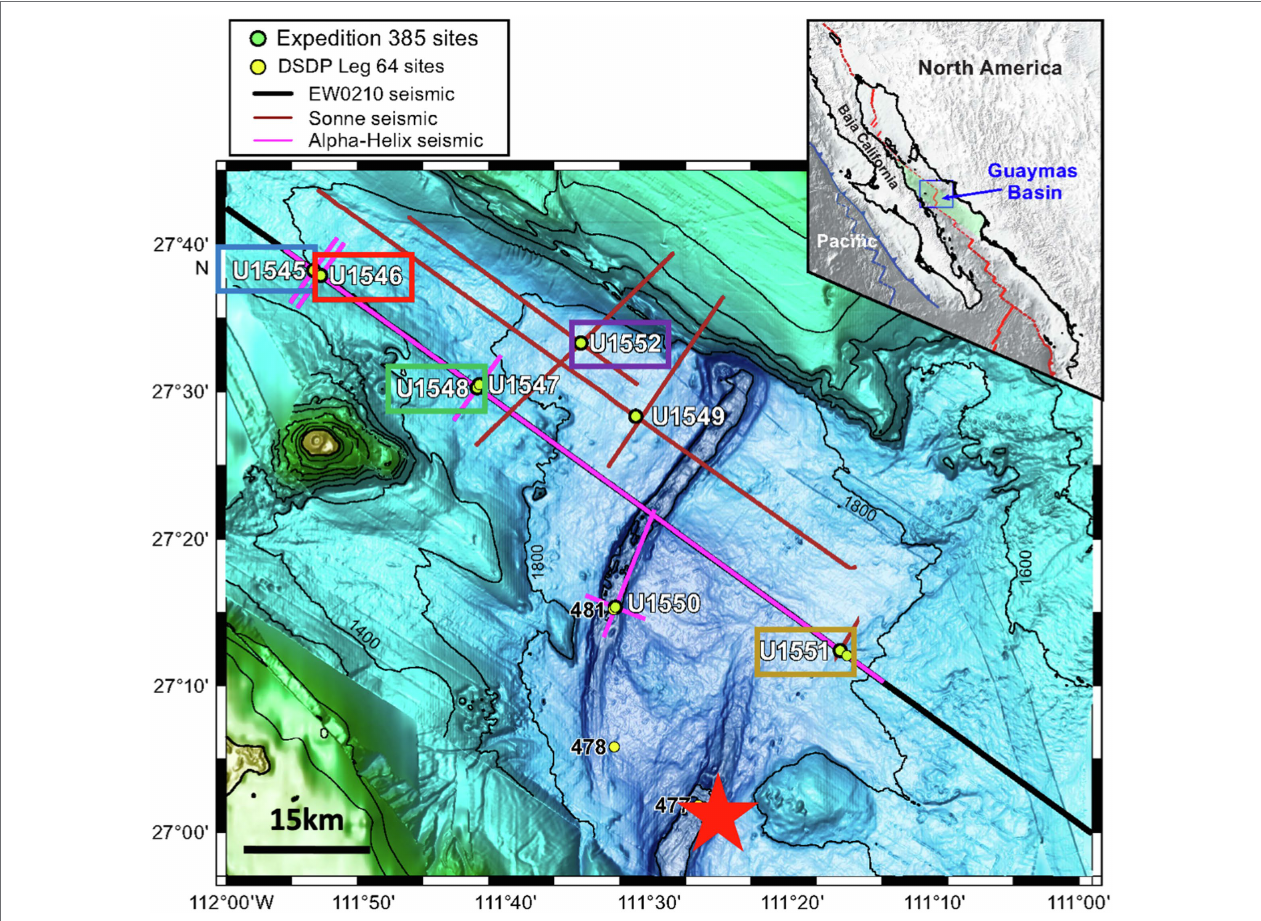
FIGURE 1 | Sampling sites in Guaymas Basin. Image adapted from Teske et al. (2020). Colored boxed indicate sampling sites where SRR could be measured. The color scheme is used for data plotted in Figures 2 – 4 . The red line in the insert map is the boundary between the North American and Pacific tectonic plates. The red star in the map indicates the sampling site of Elsgaard et al.